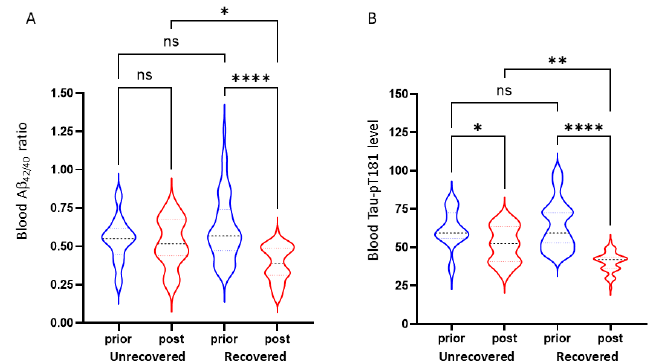
Figure 5. Blood A β 42/40 ratio (panel A ) and Tau-pT181 protein levels (panel B ) were reduced in re- covered subgroups. Group comparison was conducted using Student t -test, and the asterisks indicate a significant difference between the subgroups as indicated. * p < 0.05; ** p < 0.01; **** p < 0.0001; ns, not significant.